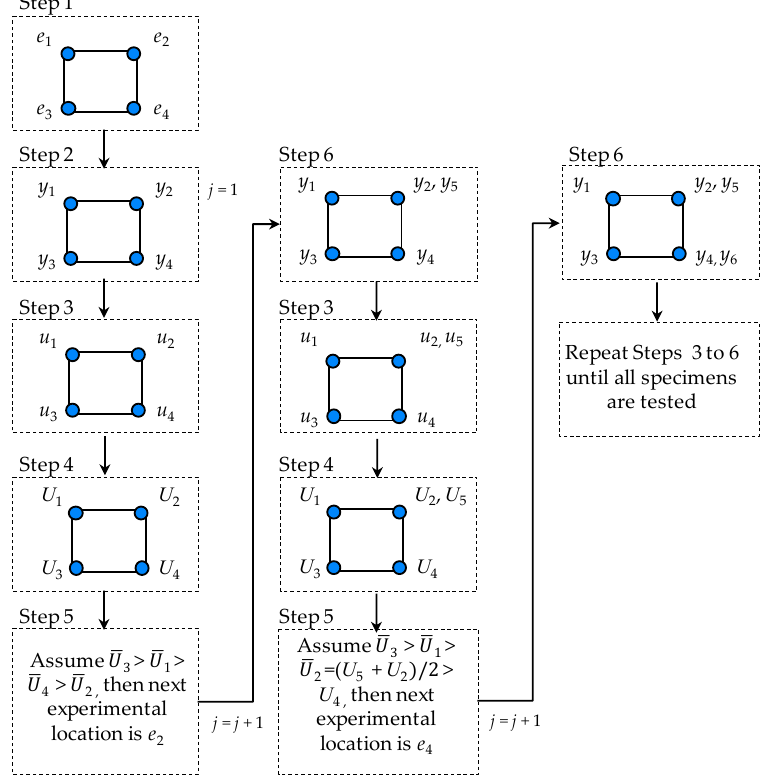
Figure 4. Example of RAED: Two-level factorial design with two design variables.